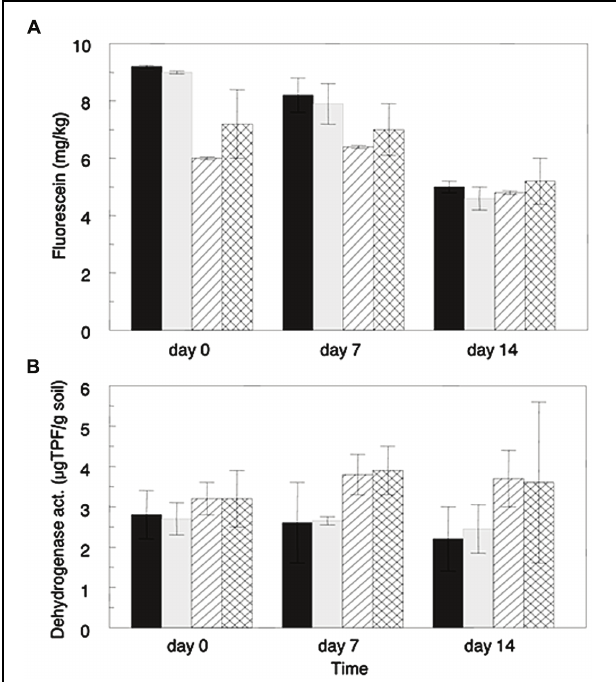
Table S6. All PCR reactions were performed in a final volume